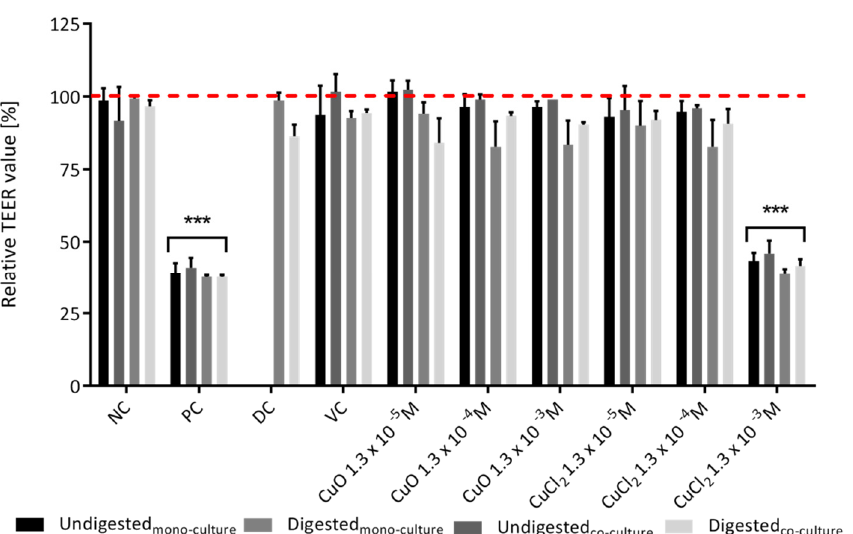
Figure 3. Impact of digested and undigested copper oxide nanoparticles on the barrier integrity of Caco-2 mono-cultures and Caco-2/HT29-MTX co-cultures. NC: negative control (cell culture medium); PC: positive control (10 mM EGTA and 0.1% Triton X-100); DC: digestion control (10% digestive juice in culturing medium); VC: vehicle control (0.05% BSA solution). The red line represents the initial TEER value before incubation. The statistical differences relative to the TEER values before treatment are marked as: *** p < 0.001. The error bars represent the standard deviation of three independent measurements.